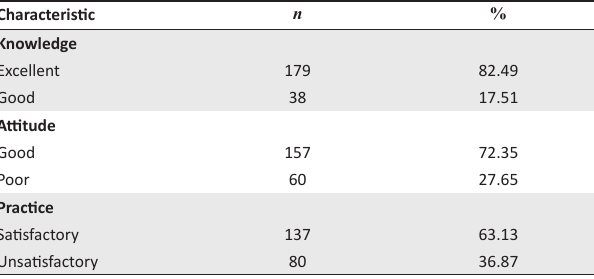
TABLE 2: Knowledge, attitudes and practices of participants.